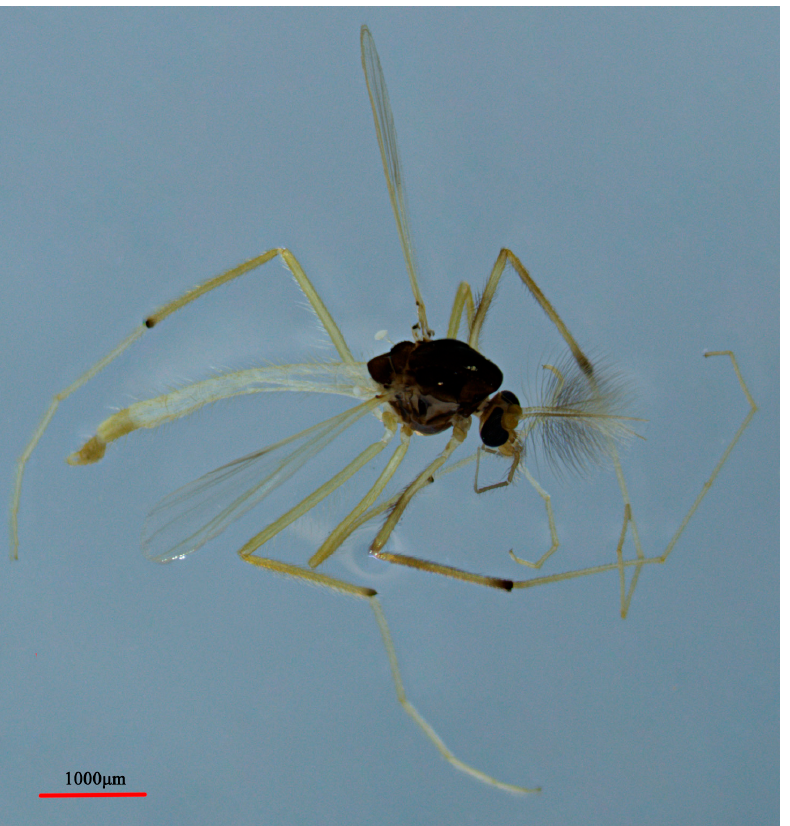
Figure 10. Male adult (holotype, in dorsal view) of M. robustus sp. nov. Diagnostic characters. The male imago can be separated from the known species of Microtendipes Kieffer, 1915 by the following combination of features: most of the antenna and antennal plumage is brown to dark brown; the thorax is uniformly dark brown; the distal half of the fore femur is light brown, with 20–24 proximally directed setae in two rows; the tibia is brown with a dark brown apical part; and it has wings without setae. Regarding the superior volsella wing, there is one basal seta and 5–8, seven setae in the middle, while the median volsella is poorly developed, with 2–2 clustered setae; the gonostylus is strong and bulb-like; and the abdomen is pale except for the